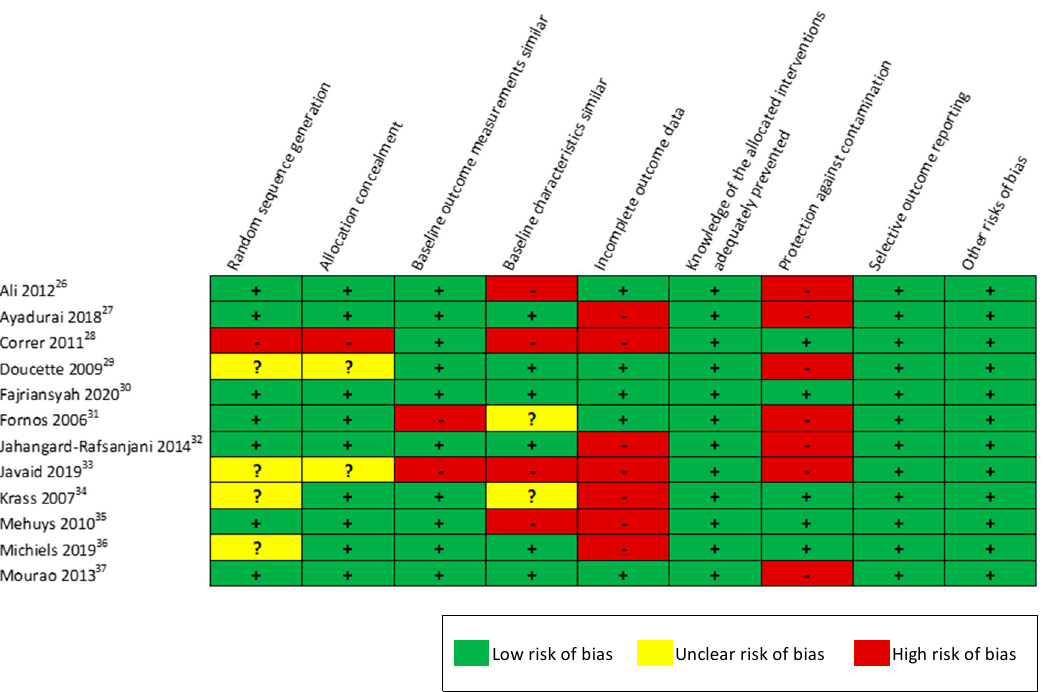
Figure A2. B2 Detailed risk of bias of the included studies.